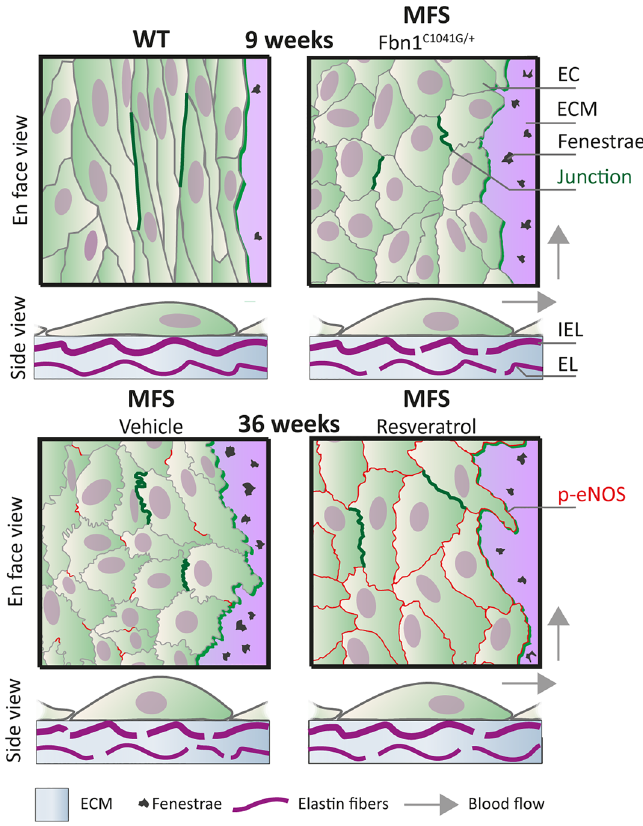
Figure 5. Overview of endothelial cell dysfunction and elastin sheet disruptions in a mouse model of MFS. Schematic presentation of endothelial cell (EC) organization and extracellular matrix (ECM) structure in the thoracic ascending aorta of WT, MFS, MFS-CTRL, and MFS-RESV mice. In the en face view, differences in EC morphology are shown and two adherens junctions connecting ECs are indicated with a dark green line to highlight the junctional linearity. Moreover, the elastin sheet on which the ECs are situated is drawn with occasional fenestrae. Expression of p-eNOS on the EC membrane is shown as red lines at the age of 36 weeks. In the side view, EC morphology is shown, and the fenestrae are now indicated as breaks in the internal elastic lamina (IEL). Part of the aortic media is shown with its ECM and a medial elastic lamina (EL) (vSMCs are not depicted). Arrows indicate blood flow